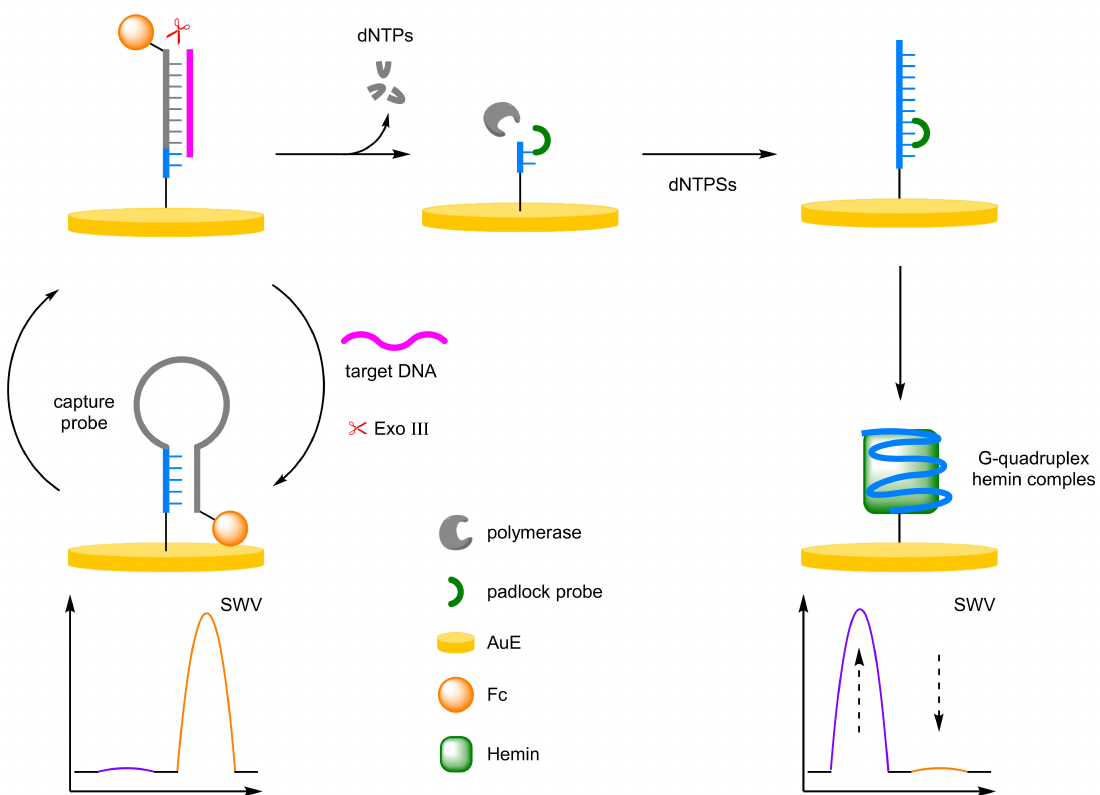
Figure 17. Schematic representation of a rolling circle amplification-based biosensor.